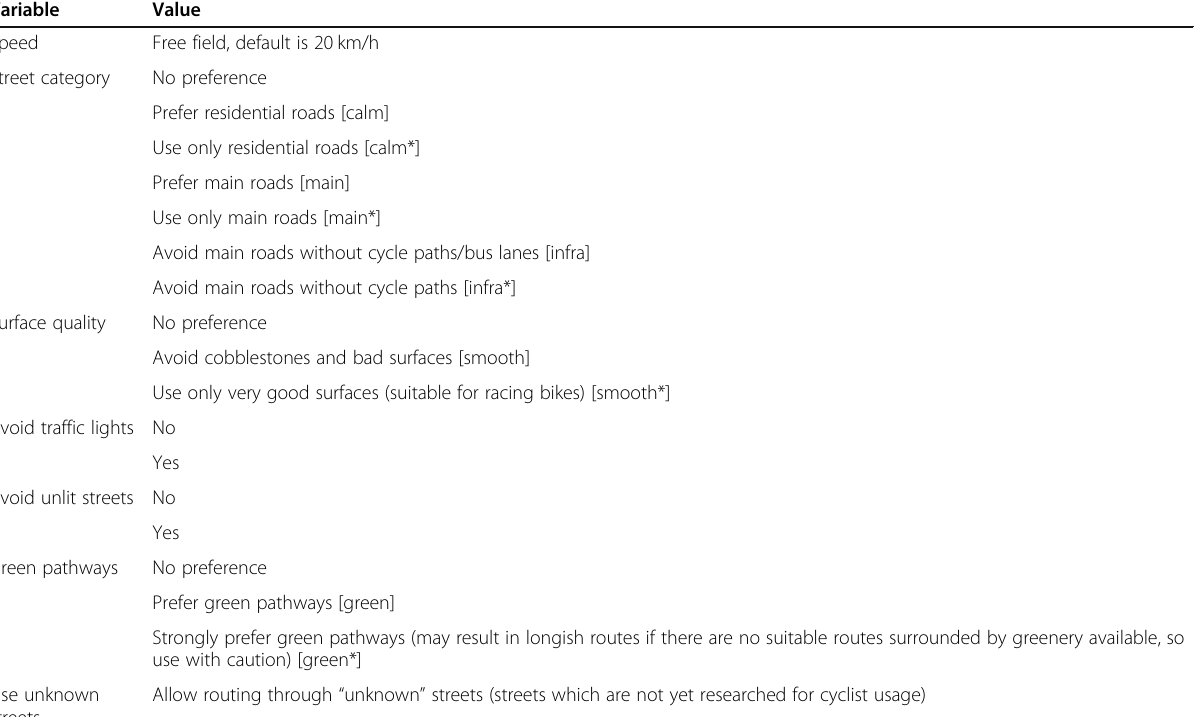
Table 1 Characteristics available for routing requests in the BBBike bike-routing engine